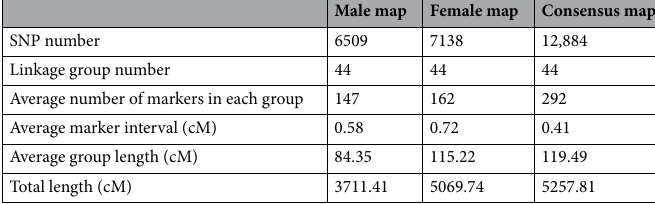
Table 2. Summary of sex-specific and consensus genetic